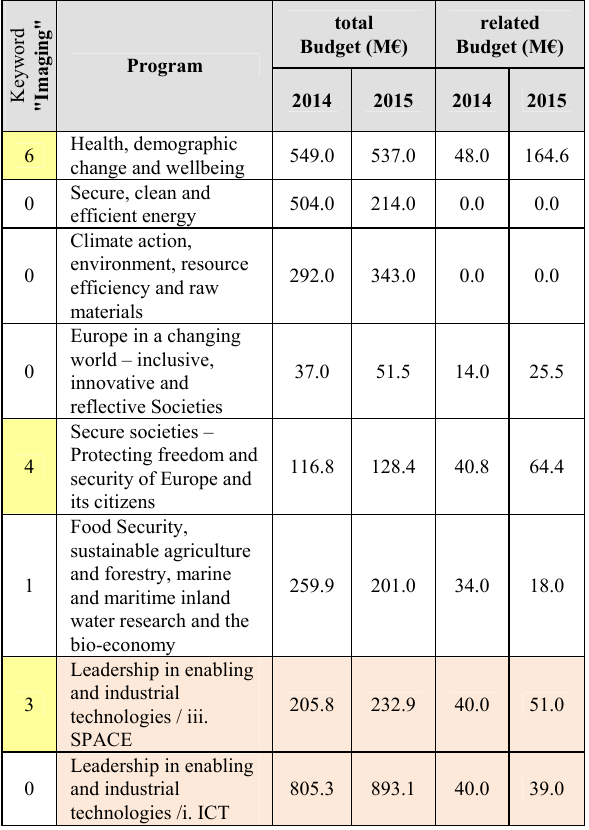
Table 4. H2020 2014/2015 calls related to “imaging” activities